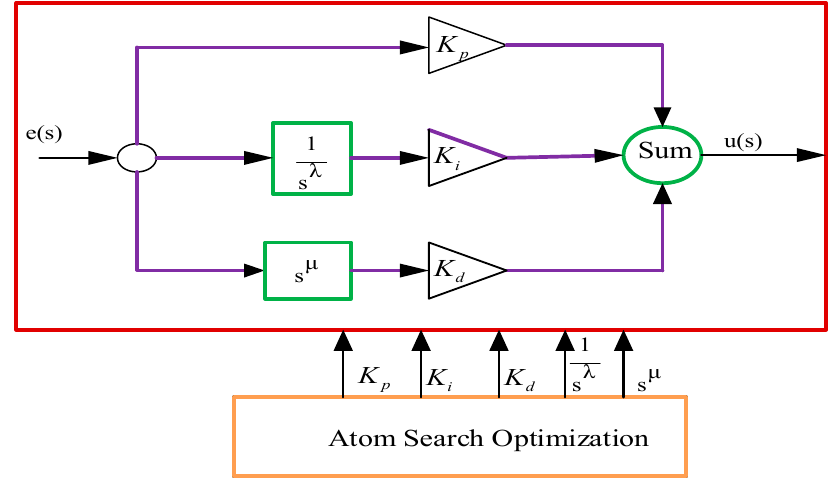
Figure 7. Control structure of FOPID.